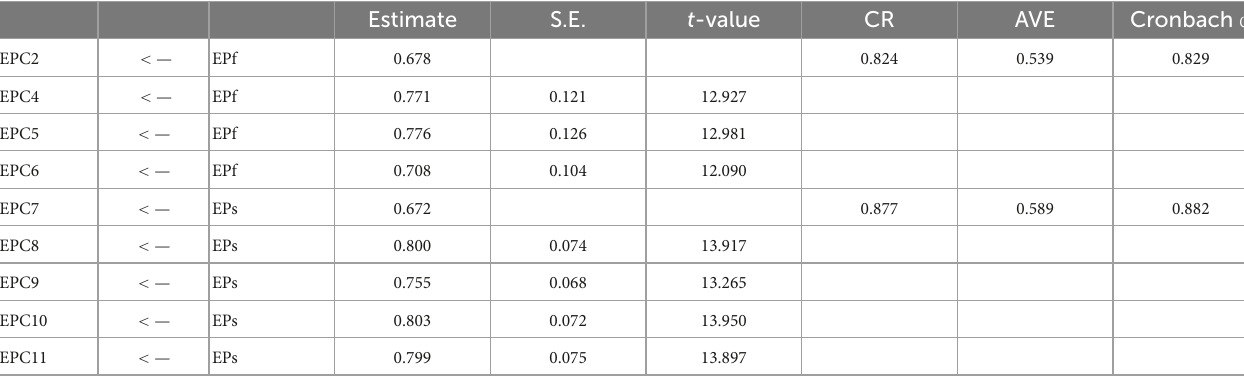
TABLE 2 Confirmatory Factor Analysis (CFA) of expected experience.